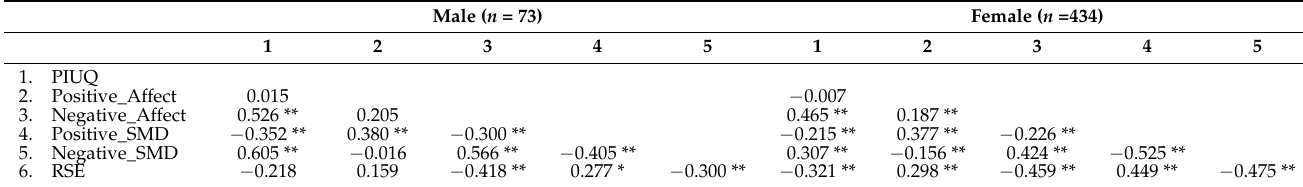
Table 3. Correlation matrix of all variables (split by gender).